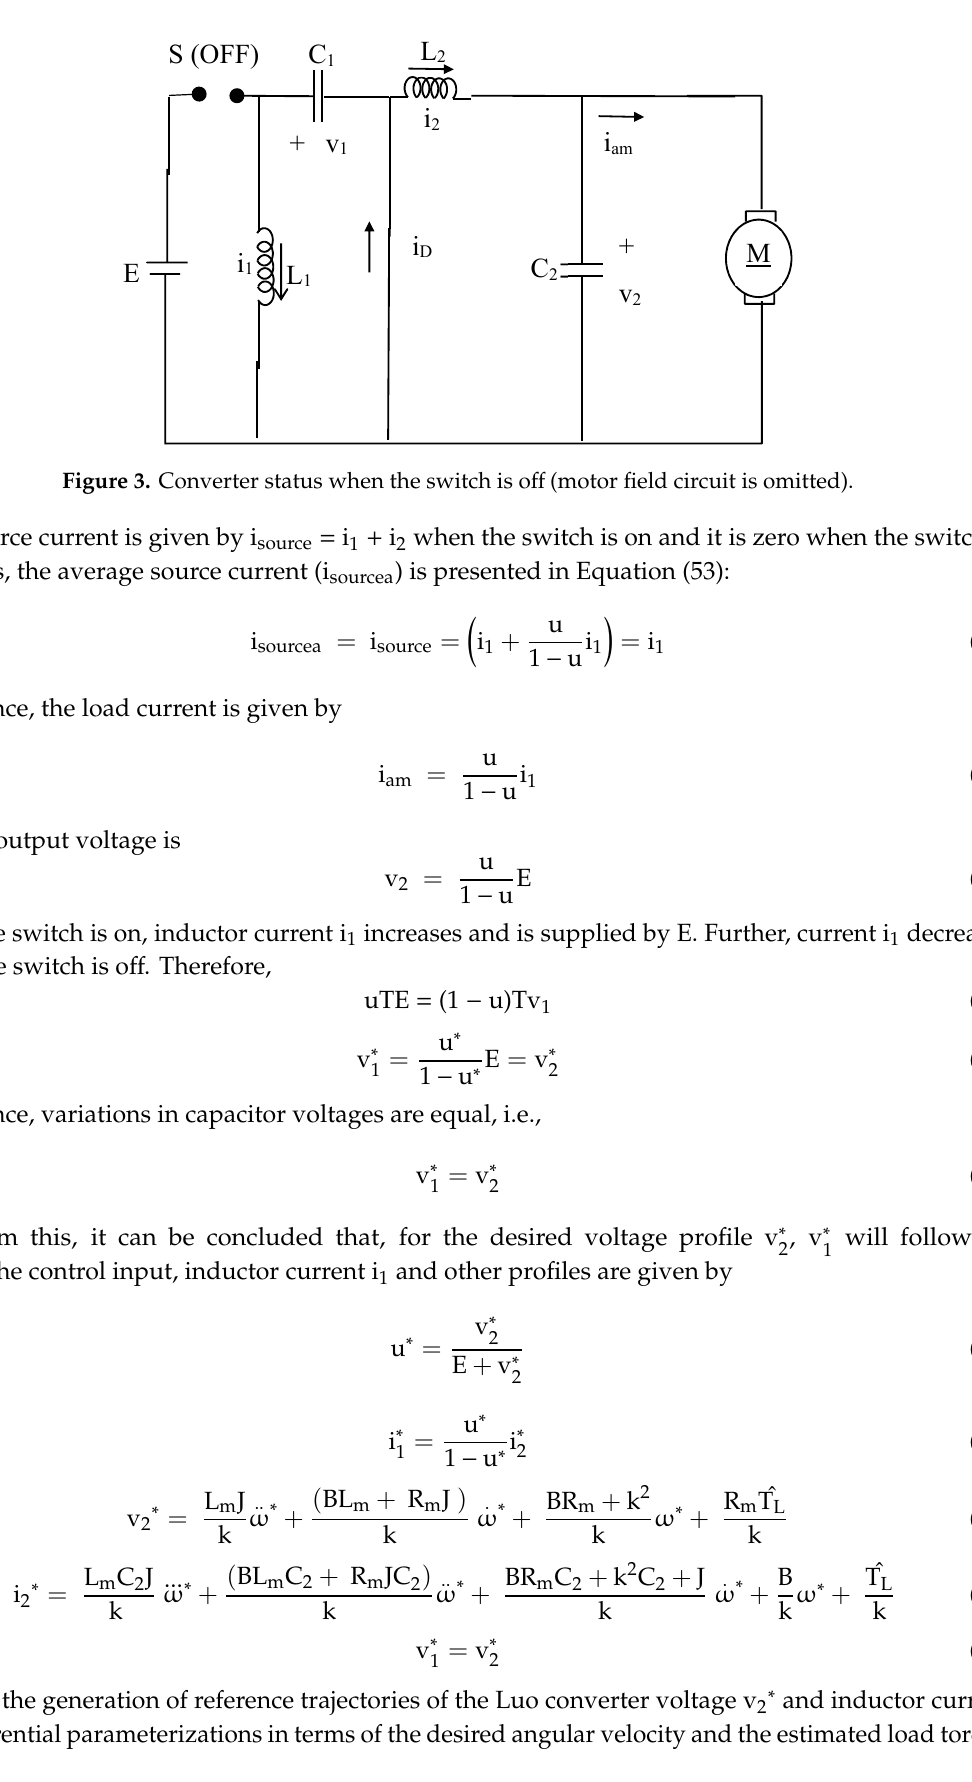
Figure 2. Converter status when the switch is on (field circuit of motor is omitted).